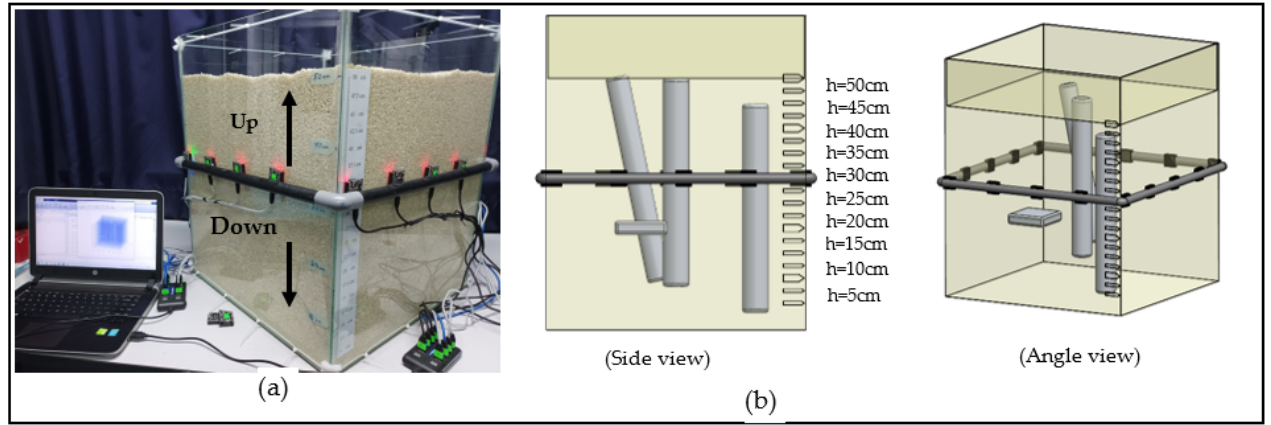
Figure 1. Rice container with the 16 Wi-Fi nodes.